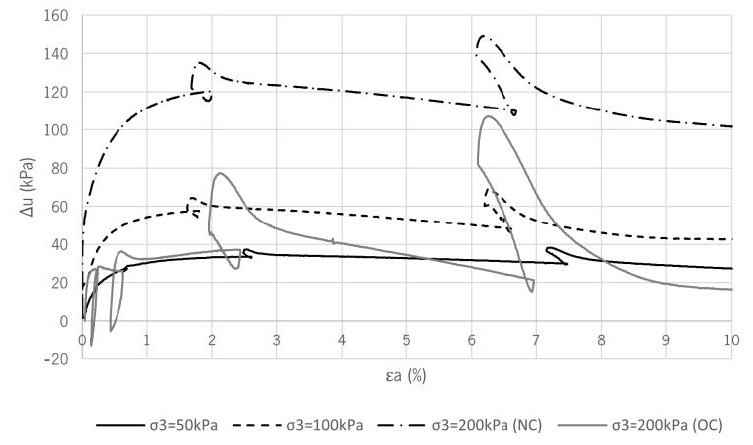
Figure 13. Evolution of pore pressure with axial strain.